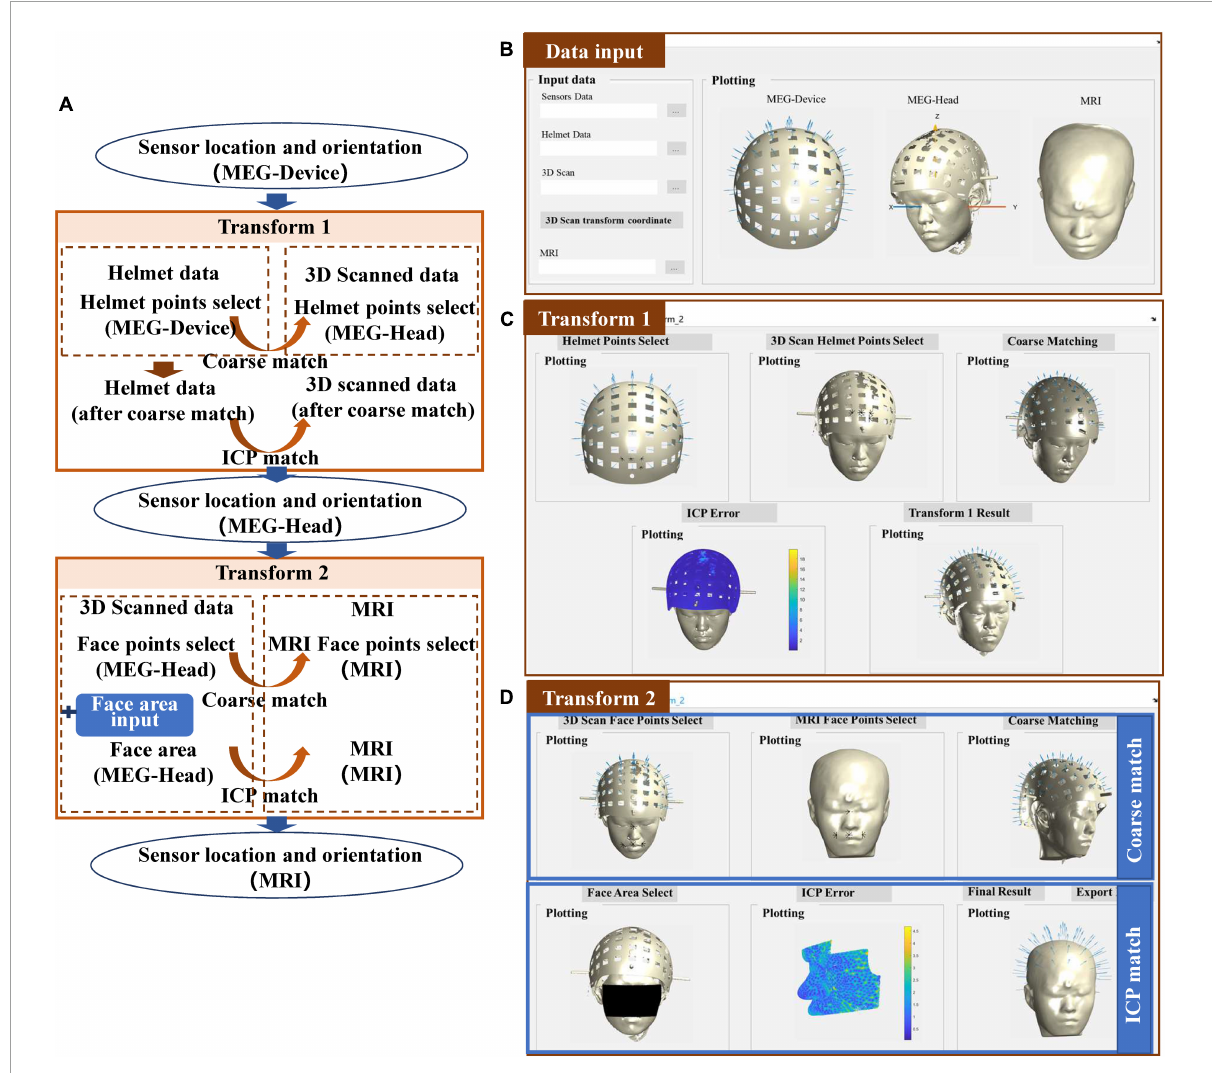
FIGURE4 (A) Workflow of the co-registration of OPM-MEG and MRI for the laser scanner; (B) interface for importing data; (C) interface for transform 1; (D) interface for transform 2.